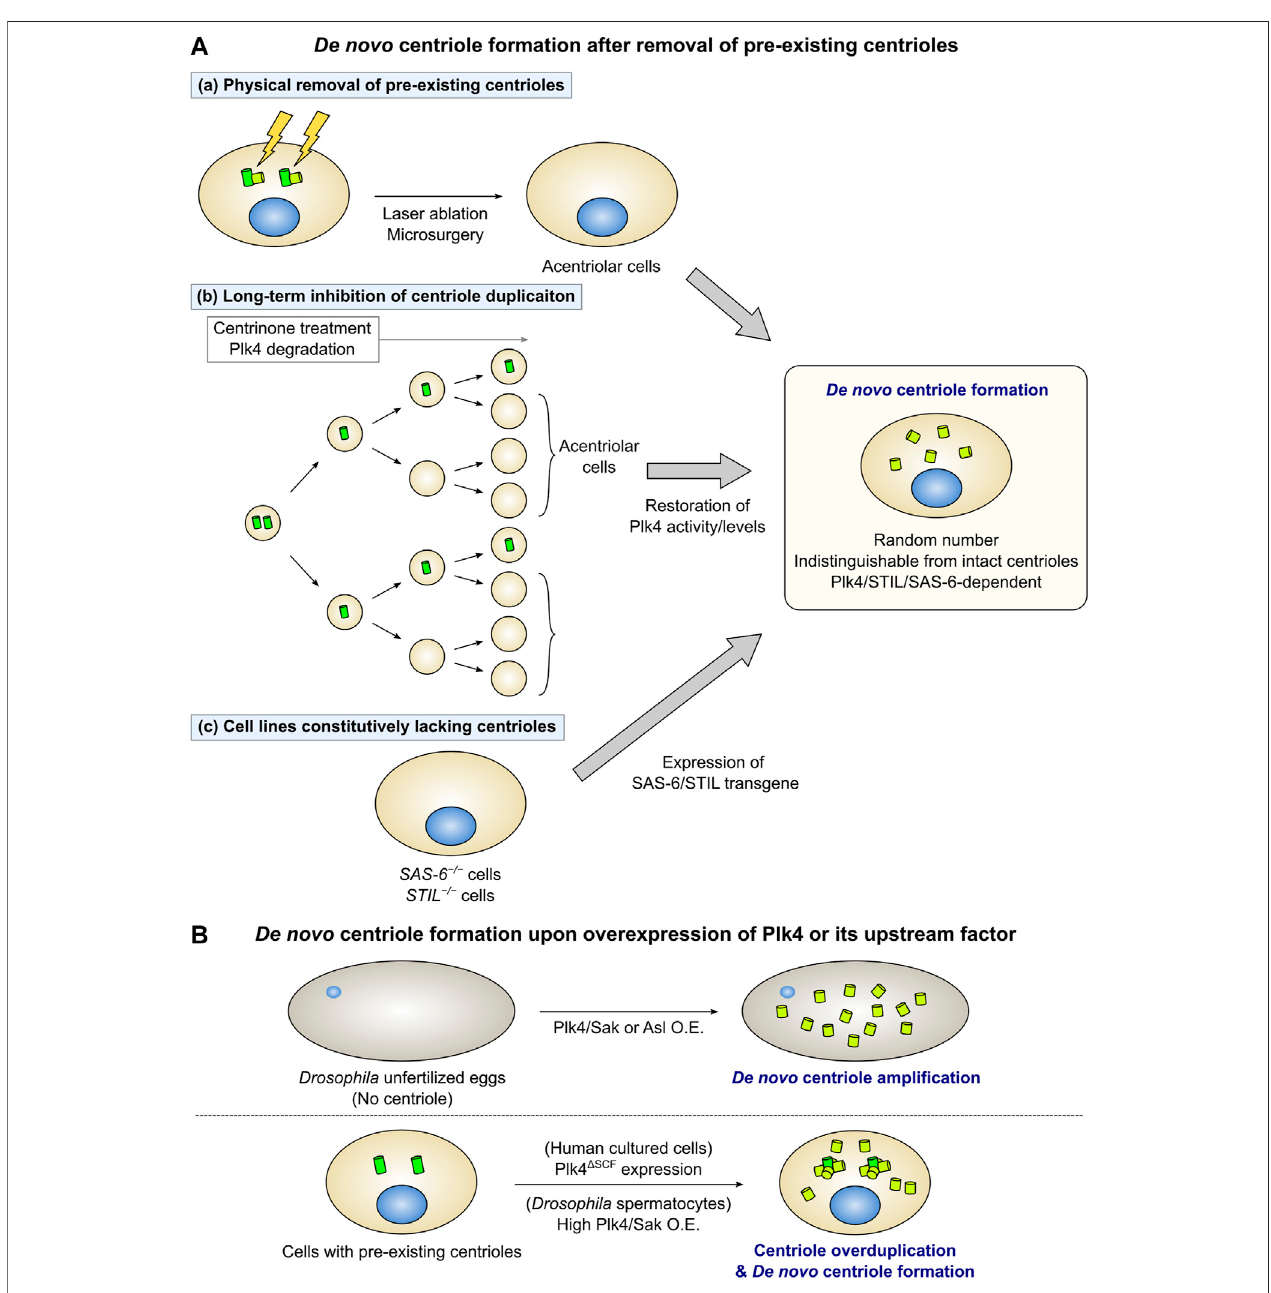
FIGURE2| Denovo centrioleformationunderexperimental conditions. (A) Removalofallthepre-existing centriolestriggers denovo centrioleformation. (a) When all the pre-existing centrioles are physically removed by laser ablation or microsurgery, new centrioles are formed de novo in the cytoplasm. (b) Long-term inhibition of centriole duplication by chronic treatment with centrinone (a Plk4 inhibitor) or Plk4 protein degradation decreases the number of centrioles in cycling cells. After the cells lose all centrioles, the restoration of Plk4 activity or levels leads to de novo centriole formation. (c) STIL/SAS-6 transgene expression in STIL/SAS-6 knockout acentriolar cells triggers de novo centriole formation. In each case, a random number of centrioles are formed de novo . Many of the centrioles formed de novo are structurally and functionally indistinguishable from intact centrioles. Additionally, the de novo pathway depends on Plk4, STIL, and SAS-6 as well as the canonical pathway does. (B) Overexpression of Plk4 or its upstream factor can induce de novo centriole formation. (Upper) In Drosophila unfertilized eggs, which do not have a centriole,overexpressionofPlk4/SakorAslinduces denovo centriole ampli fi cation. (Lower)ExpressionofPlk4 Δ SCF (anundegradable mutant ofPlk4) inhuman cultured cells leads to de novo centriole formation, in addition to centriole overduplication from the pre-existing centrioles. High levels of Plk4/Sak overexpression in Drosophila primary spermatocytes also induce de novo formation and overduplication of centrioles.